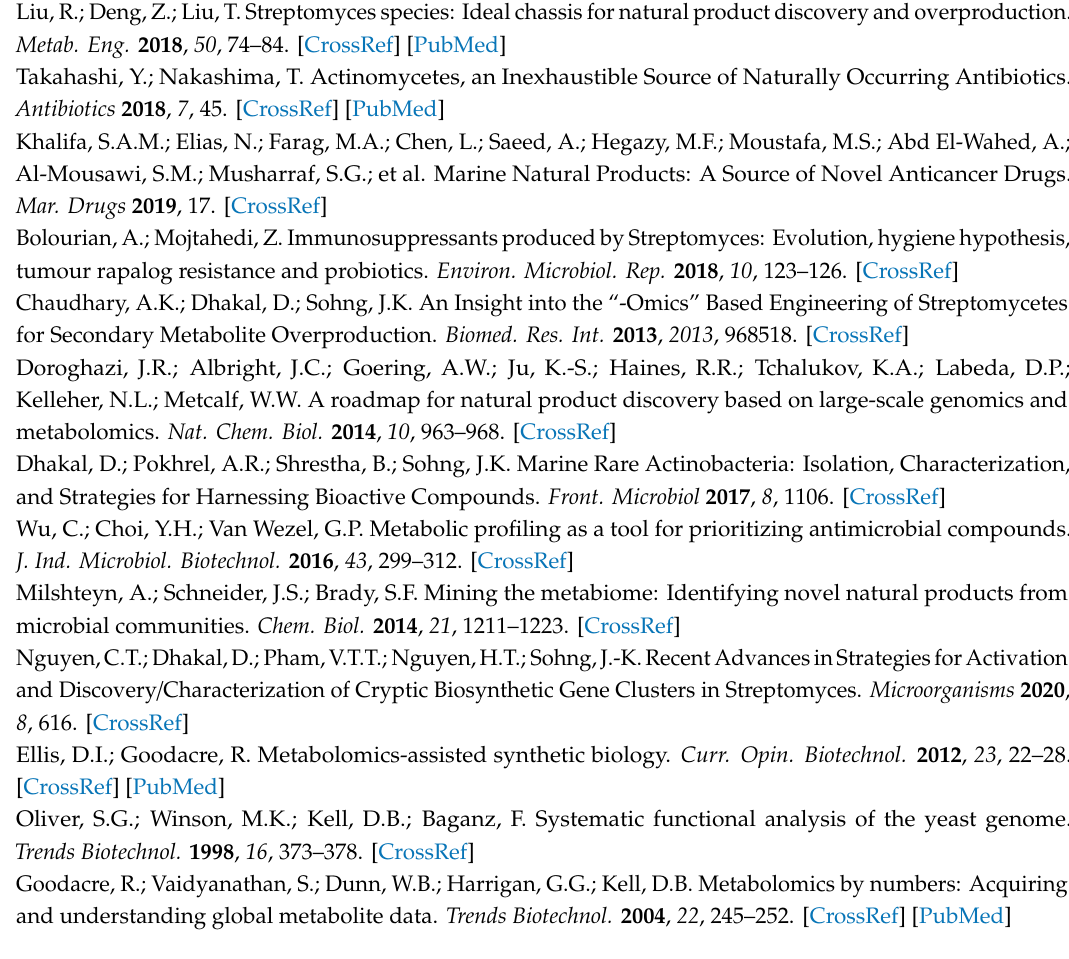
Table S1: List of the significant metabolites detected in Manchester laboratory, and identified using the PCA loadings plot. All identifications are based on minimum metabolite reporting standards, Table S2: List of the significantmetabolitesdetected inLeuvenlaboratory, andidentified usingthePCAloadings plot. All identifications are based on minimum metabolite reporting standards, Figure S1: Typical GC chromatograms of S. lividans cell extracts detected via the GC-MS platforms employed at (a) Manchester and (b) Leuven